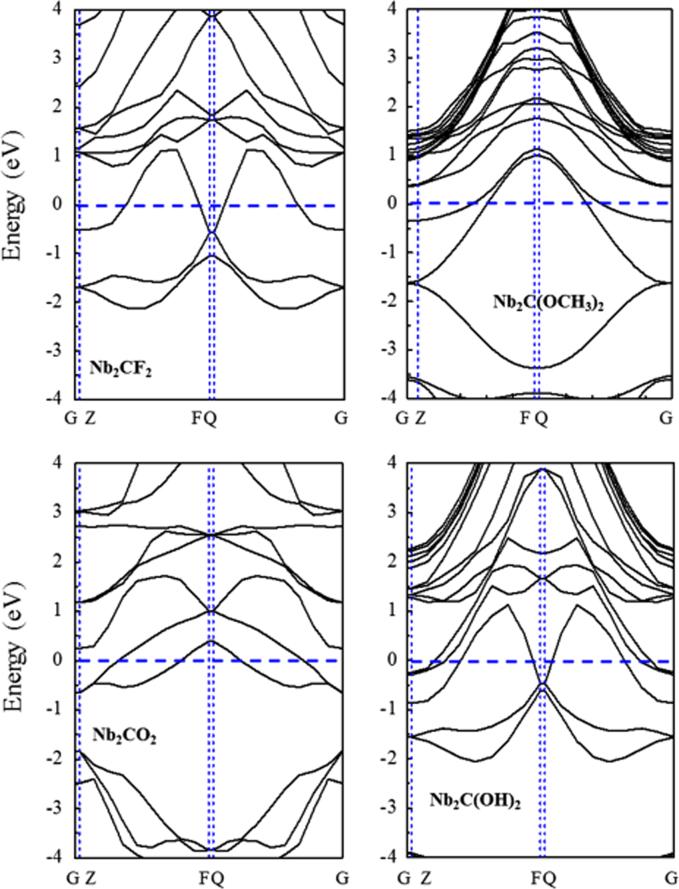
Band structures of Nb2CZ2 (Z = F, O, OH, OCH3).